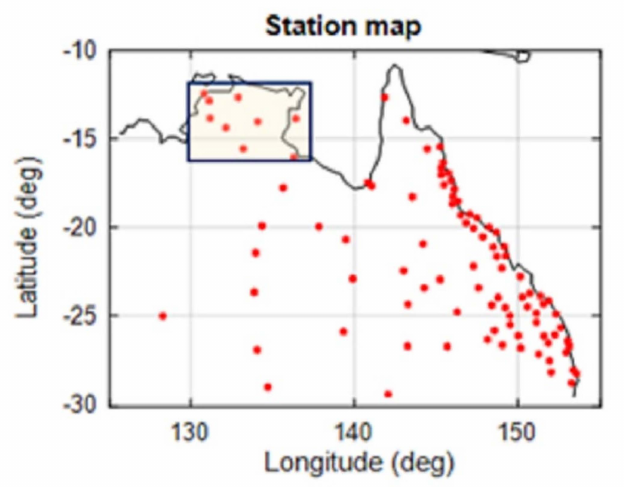
Figure 6. Map showing the GNSS CORS stations (red stars) in NT and QLD. The yellow box indicated the nominated test region for